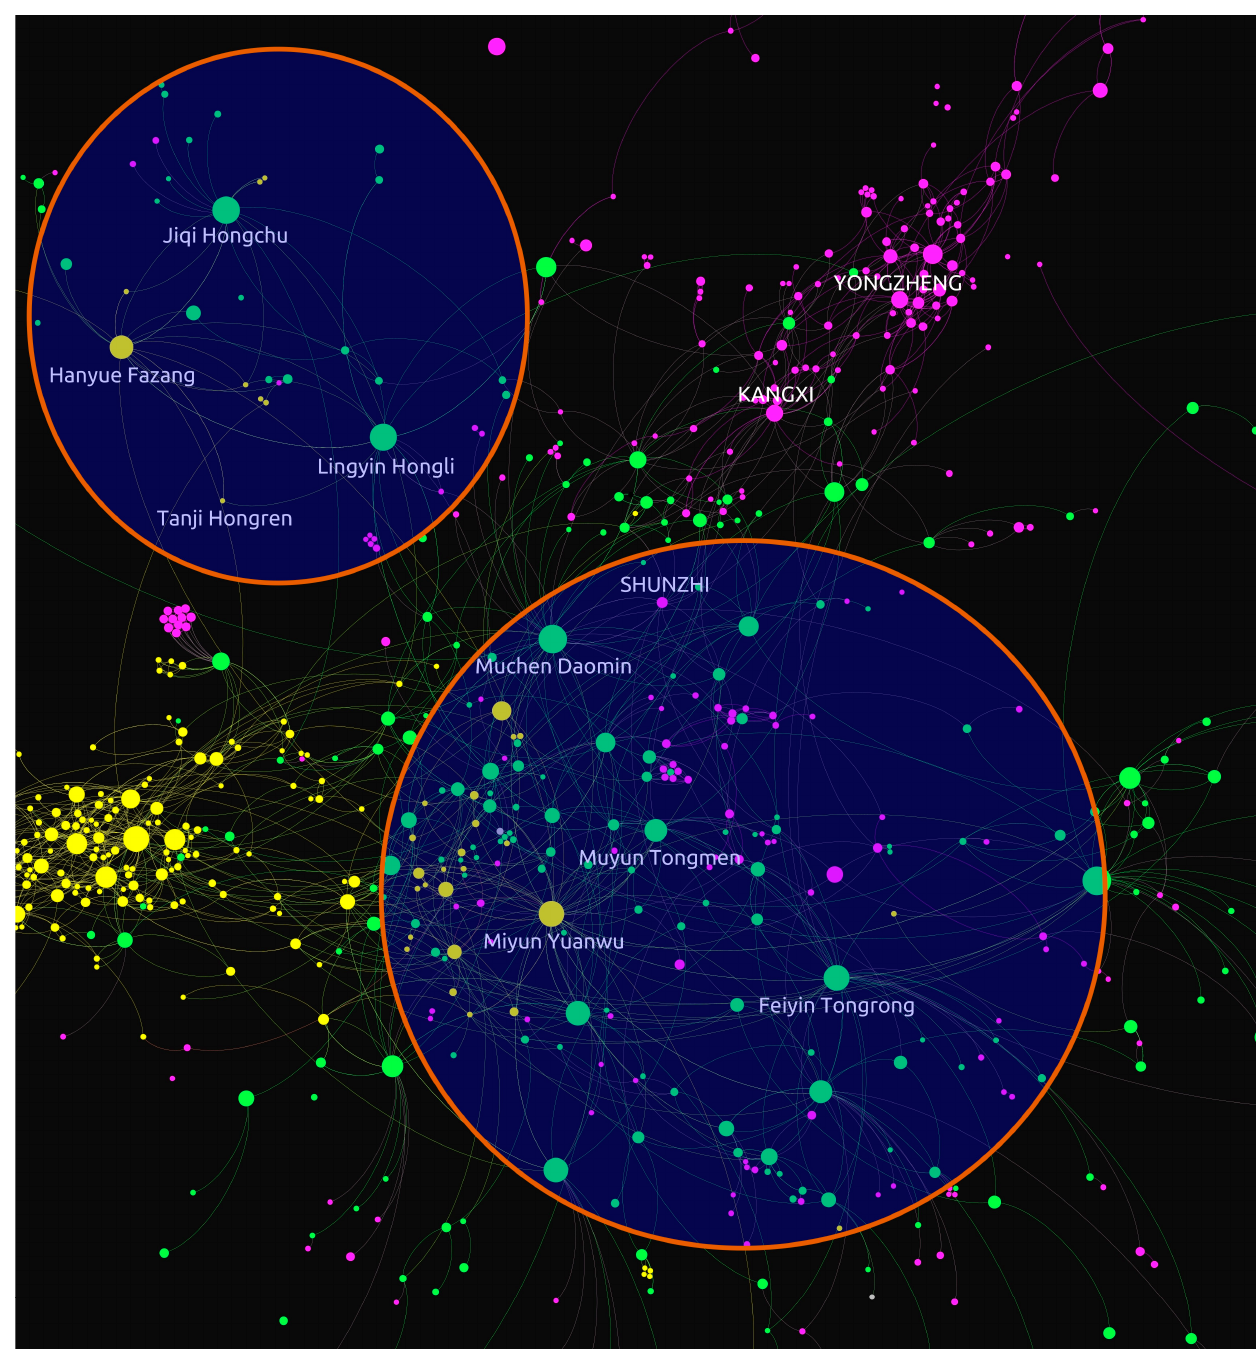
Figure 5. Miyun vs. Hanyue (nodes sized by degree; only nodes with degree > 4 are shown). Yellow nodes: actors born and died in the Ming. Green nodes: born in the Ming and died in the Qing. Magenta nodes: born and died in the Qing.